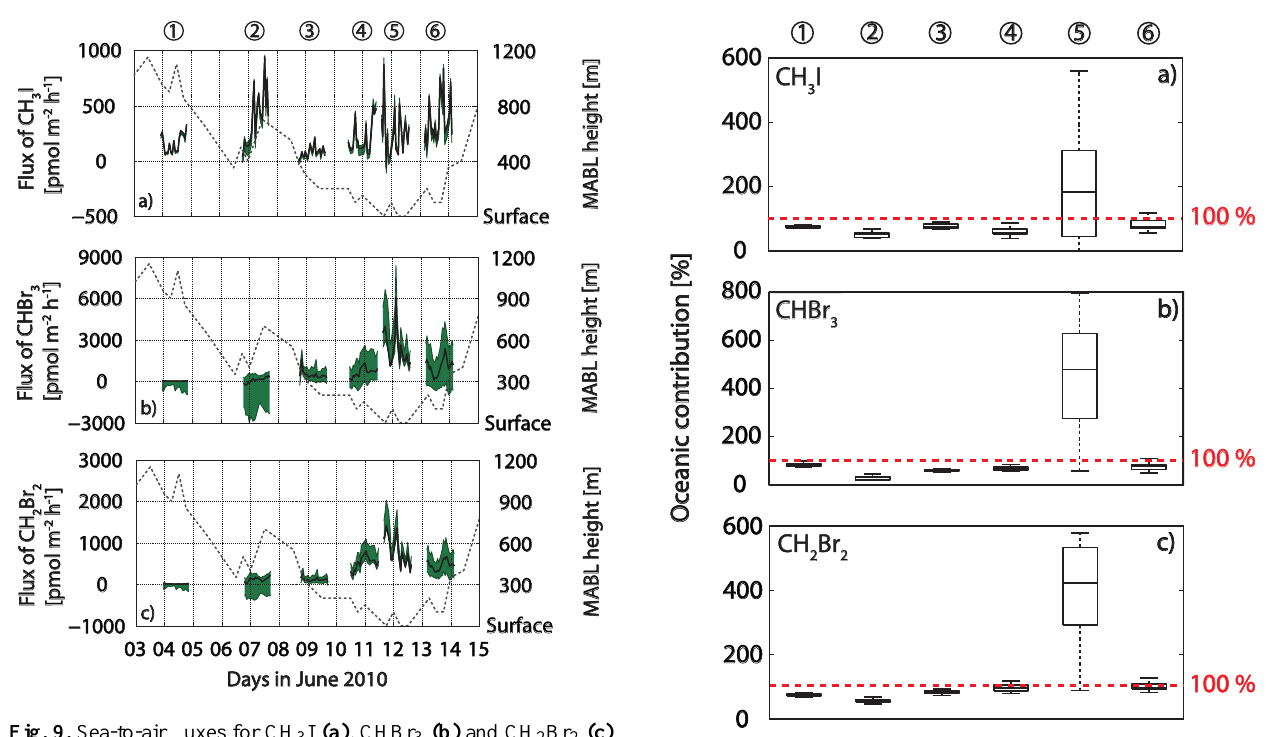
Fig. 10. Oceanic contributions to atmospheric halocarbons assum- ing a mean distance of 200km, mean wind speeds, mean sea-to-air fluxes and background mixing ratios for the open ocean (CH 3 I = 0.50ppt, CHBr 3 =0.50ppt, CH 2 Br 2 =0.75ppt) and the coastal re- gion (CH 3 I=0.75ppt, CHBr 3 =3.00ppt, CH 2 Br 2 =1.80ppt), and the MABL heights determined by Fuhlbrügge et al. (2013) at every measurement point for CH 3 I (a) , for CHBr 3 (b) and for CH 2 Br 2 (c) , outliers are excluded. The red dashed line marks 100% in every